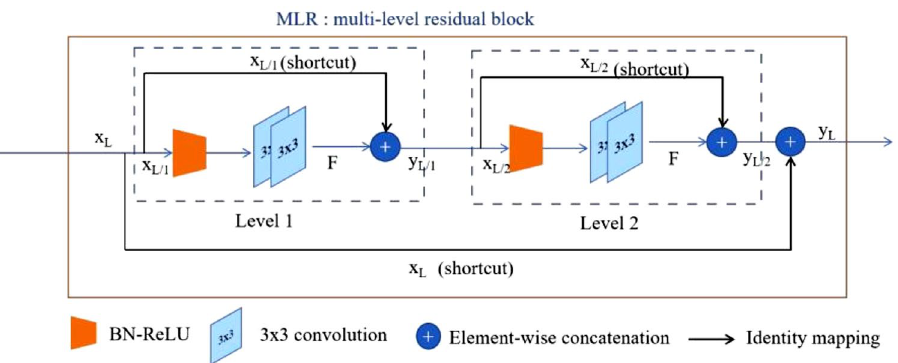
Figure 3. In this study, we propose to incorporate the residual-of-residual connection 24 as non-linear skip connection prior to combining features extracted from the encoder to the decoder. We denote these non-linear layers as the MLR block. The MLR block contains two levels, each having a sequence of BN-ReLU followed by two 3 × 3 standard convolutions with a residual connection.